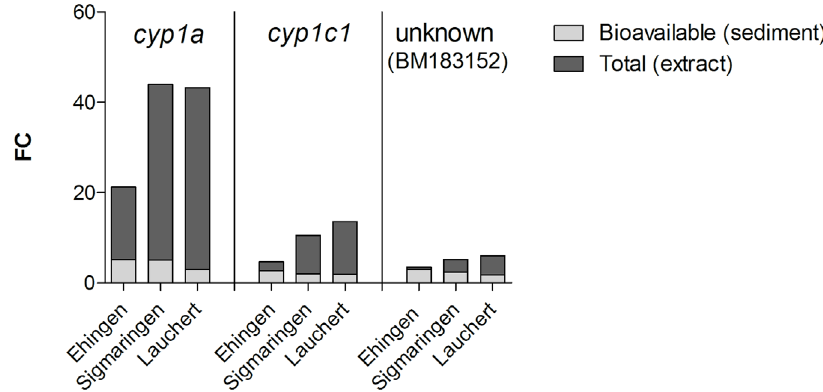
Figure 4. Changes in gene expression of cyp1a , cyp1c1 and the unknown gene (BM183152) given in fold-changes (FC) for whole sediment and extract exposure scenarios to illustrate the contribution of bioavailable contaminants (light-grey bars) to the gene regulation induced by total organically extractable contaminants (dark-grey bars).